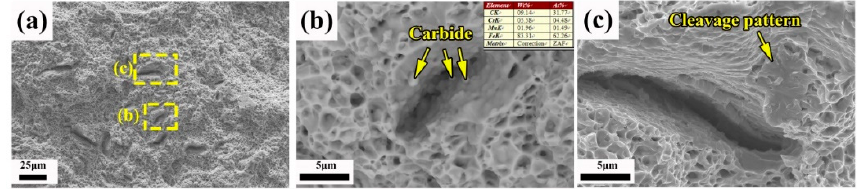
Figure 13. ( a ) The local topography, ( b ) the Backscatter image, and ( c ) the secondary electron image showing the secondary crack of the 90° sample.